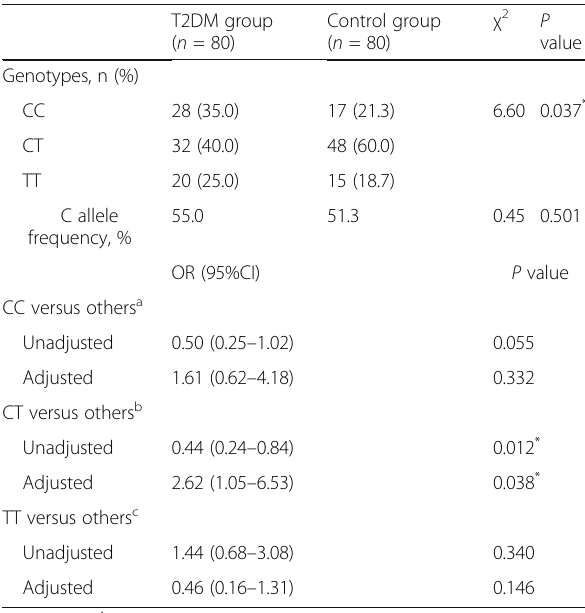
Table 3 Genotype distributions of the ATM rs189037 and the association with T2DM in males ( n =